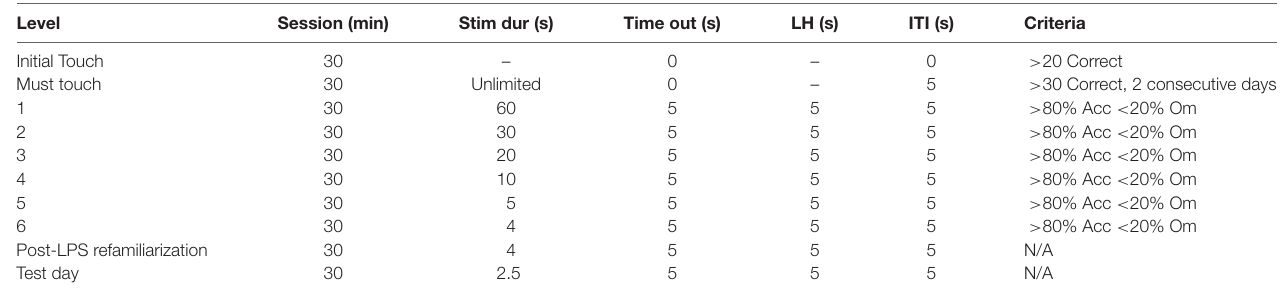
TABLE 2 | Sholl analysis parameters. Primary